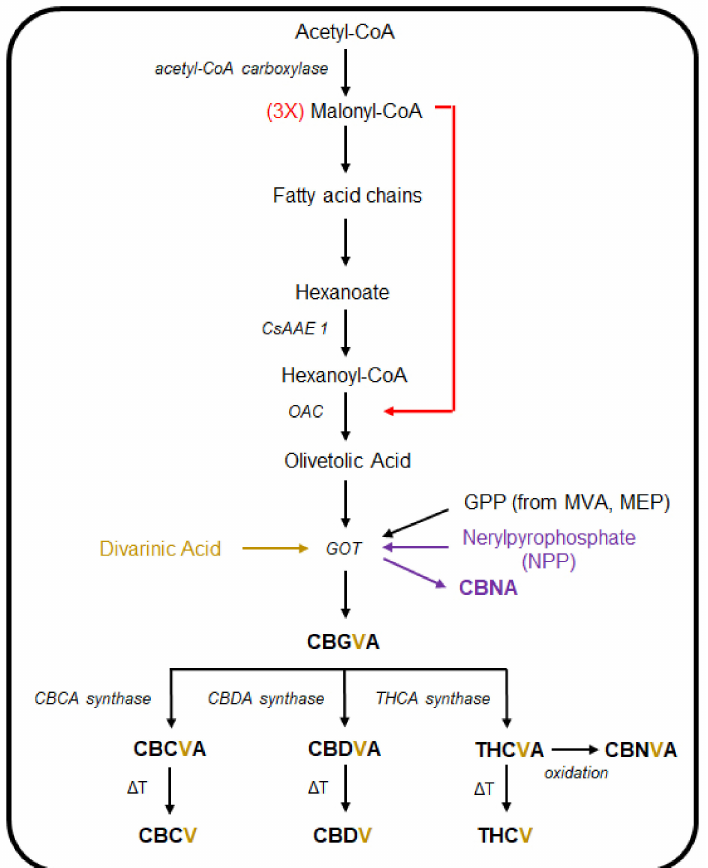
Figure 3. An overview of the cannabinoid biosynthesis pathway in Cannabis sativa . Malonyl-CoA, formed from acetyl-CoA, is used downstream with hexanoyl-CoA to produce olivetolic acid (OA). Next, OA is used as substrate along with other biomolecules by the GOT enzyme to produce the major cannabinoid precursor, CBGA. When GOT uses substrates additional to OA, such as divarinic acid or nerylpyrophosphate, a range of other minor cannabinoids are